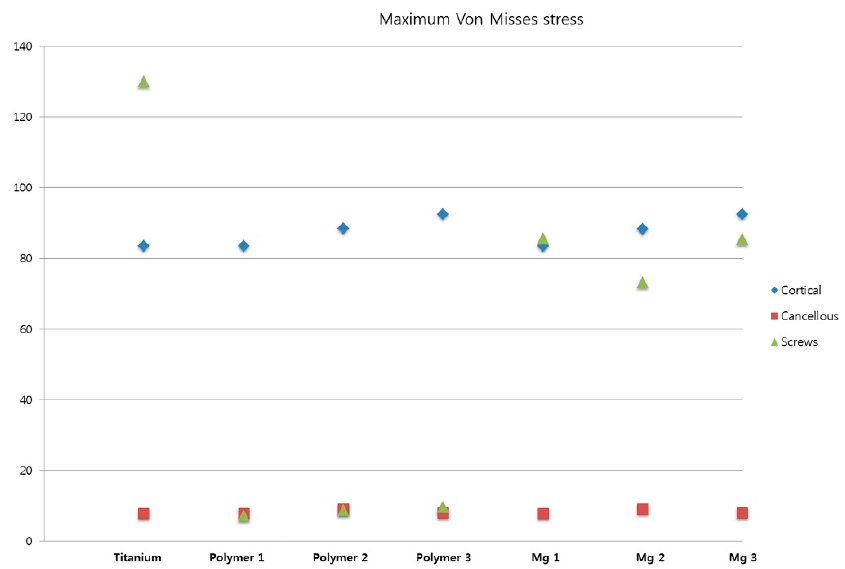
Figure 6. Maximum von Mises stress in each component of the model. Reproduced with permission from [75], Elsevier, 2017. Table 2. Maximum von Mises stress under the given conditions (MPa). Reproduced with permission from [75], Elsevier, 2017.